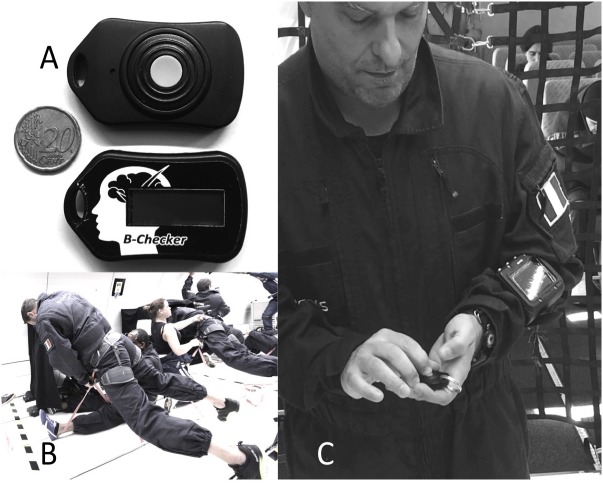
(A) The B-Checker device, note the LED position just above the gray button (little hole), it is located at the opposite side of the display, hence the operator is not aware of the result before completing the test. (B,C) First author (CB) testing the device during the microgravity and hypergravity phase; the free-floating phase is performed while securely fasten to the ground by means of a rappel harness, the participant faced the ground with no direct light directed to the flickering led nor on the participant eyes.